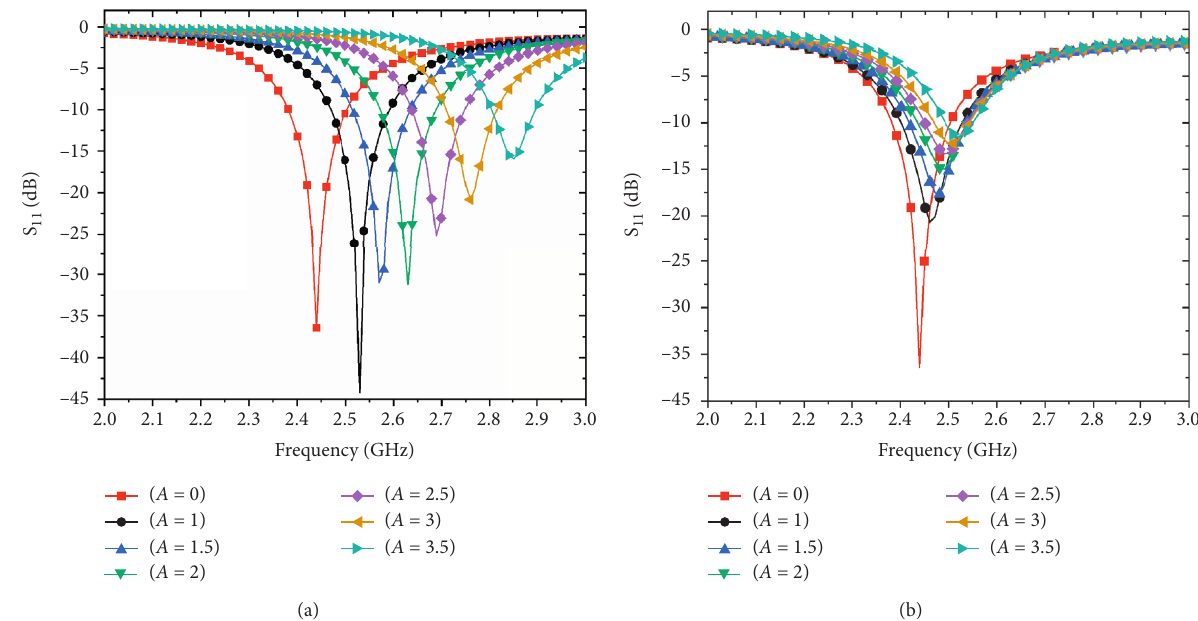
Figure 13: Measured results of S parameter. (a) Case a and (b) case